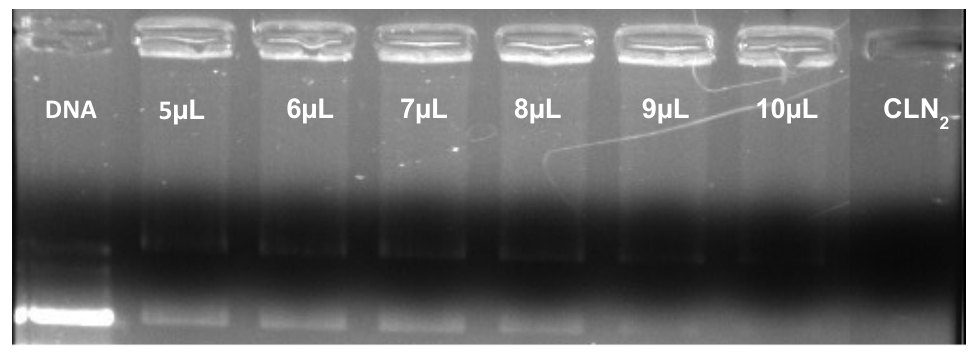
amount on the compaction of 2